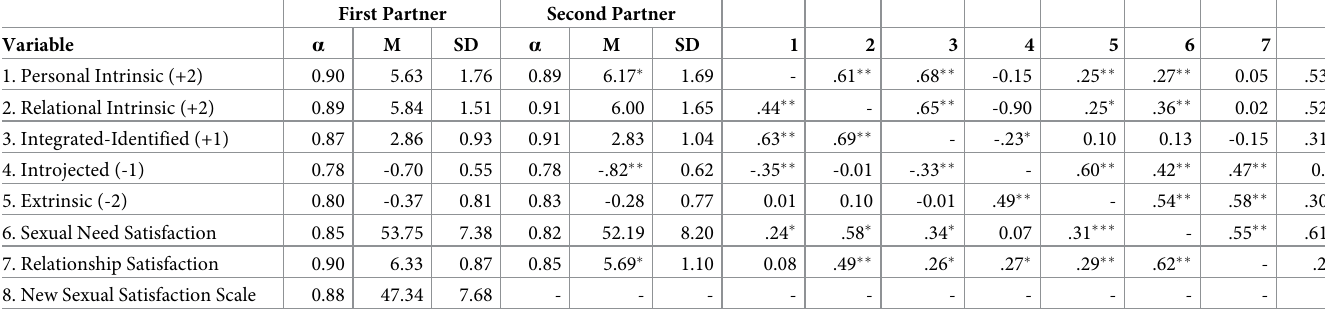
Table 2. Cronbach alphas, descriptive statistics and correlations for key variables for first partner and second partner at intake survey. First